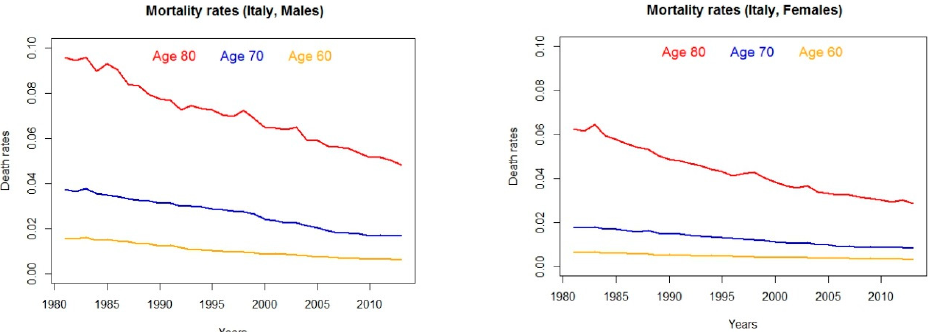
Figure 1. Observed death rates for Italian male and female populations at selected ages.